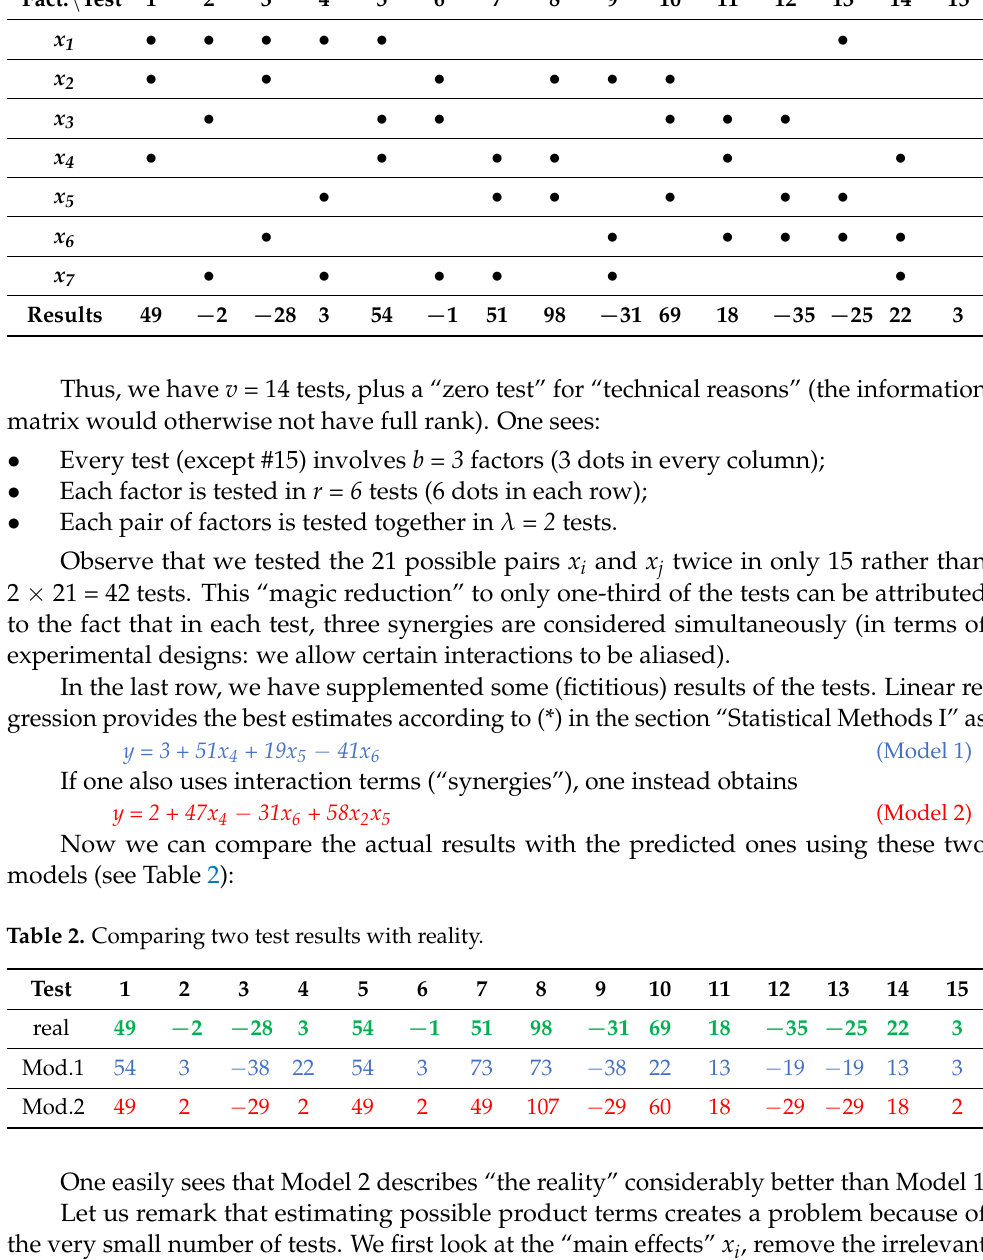
Table 1. An experimental design for testing 7 factors, each of them 6 times. Fact. \ Test 1